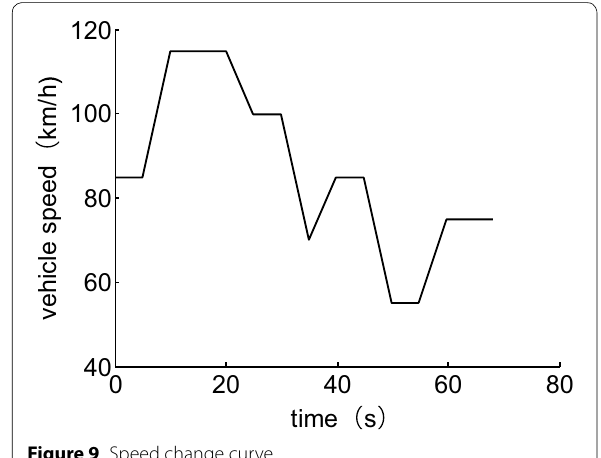
Figure 9 Speed change